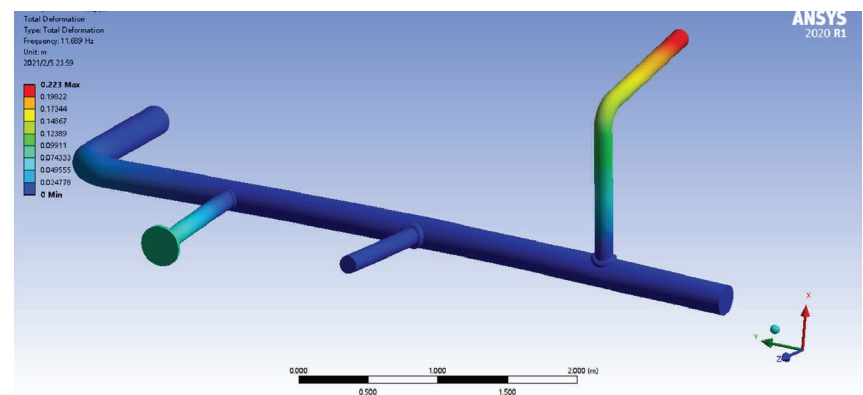
Figure 12: First modal shape of model 1.